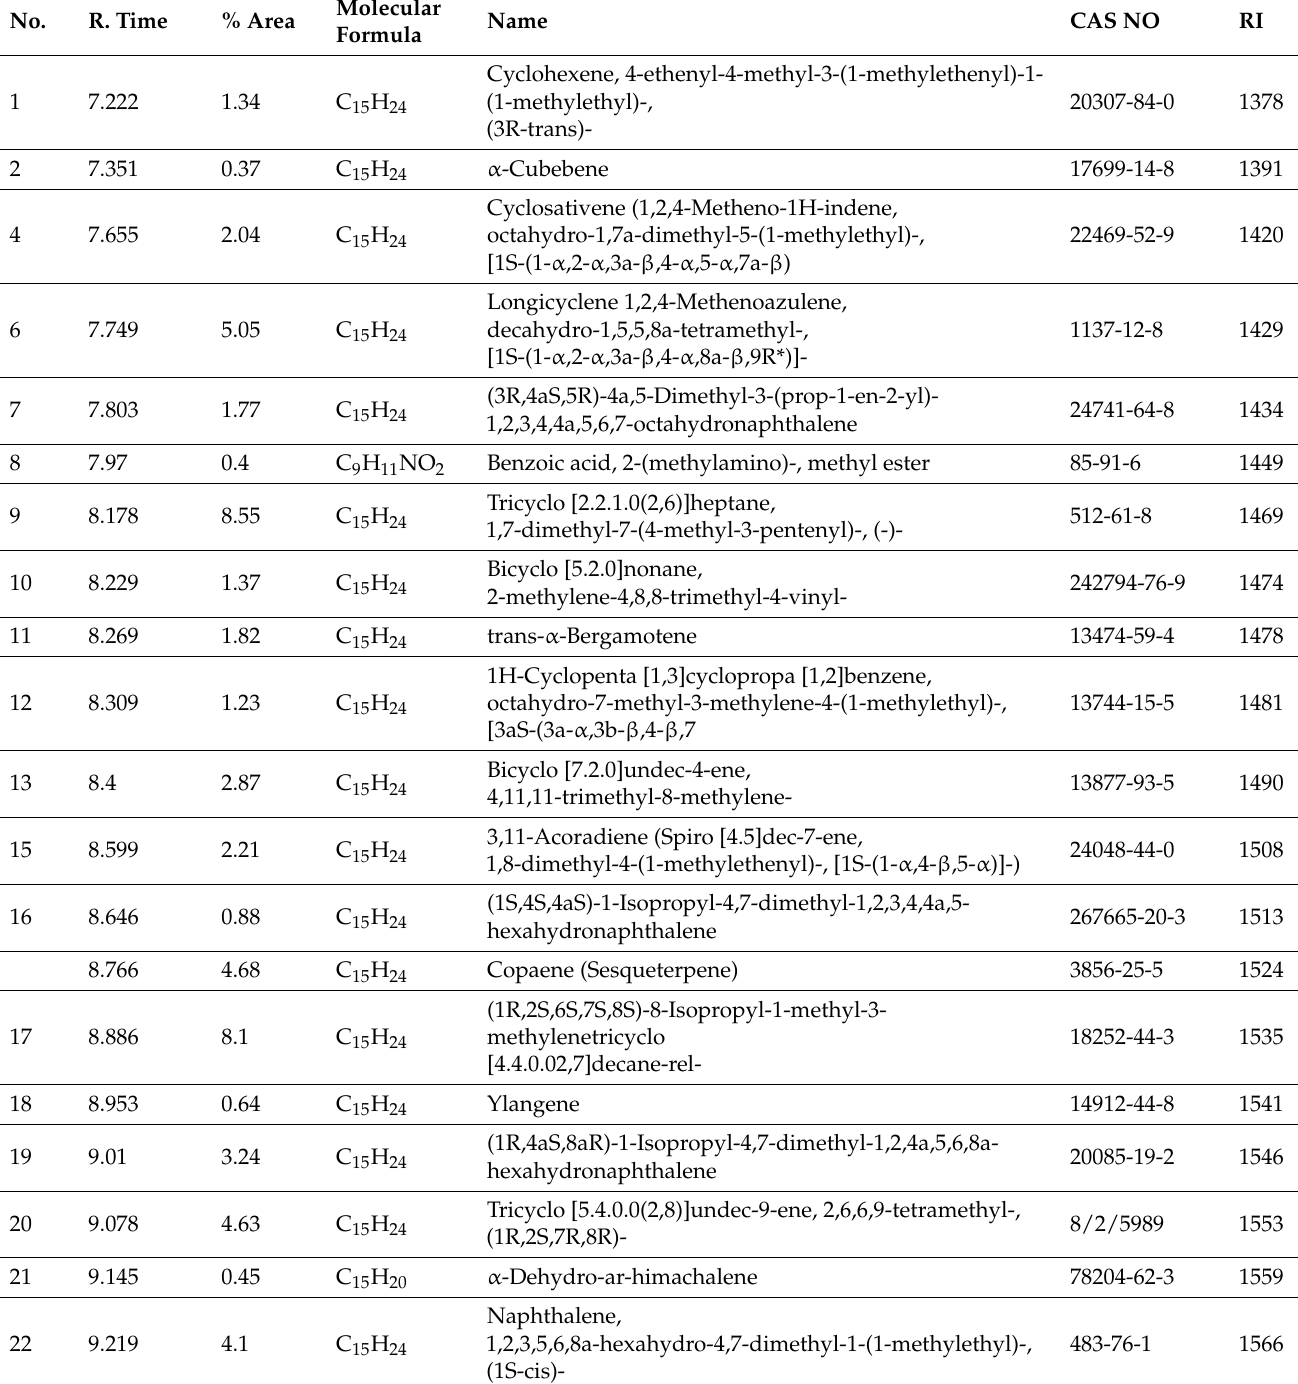
Table 13. Chemical composition of volatile oil (VO) from the root bark of T. Ciliata by GC-MS/MS.